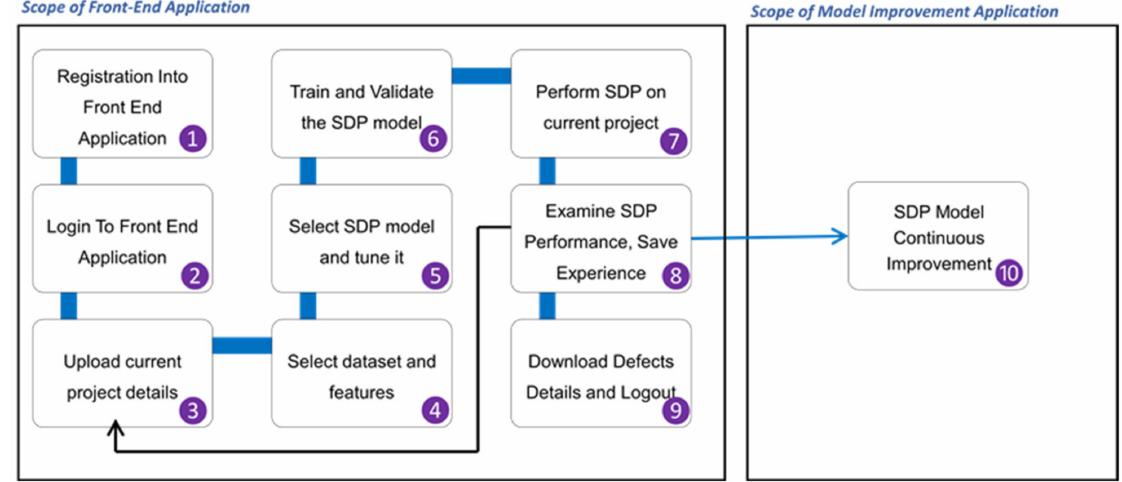
Figure 3. Novel DePaaS Process for use with